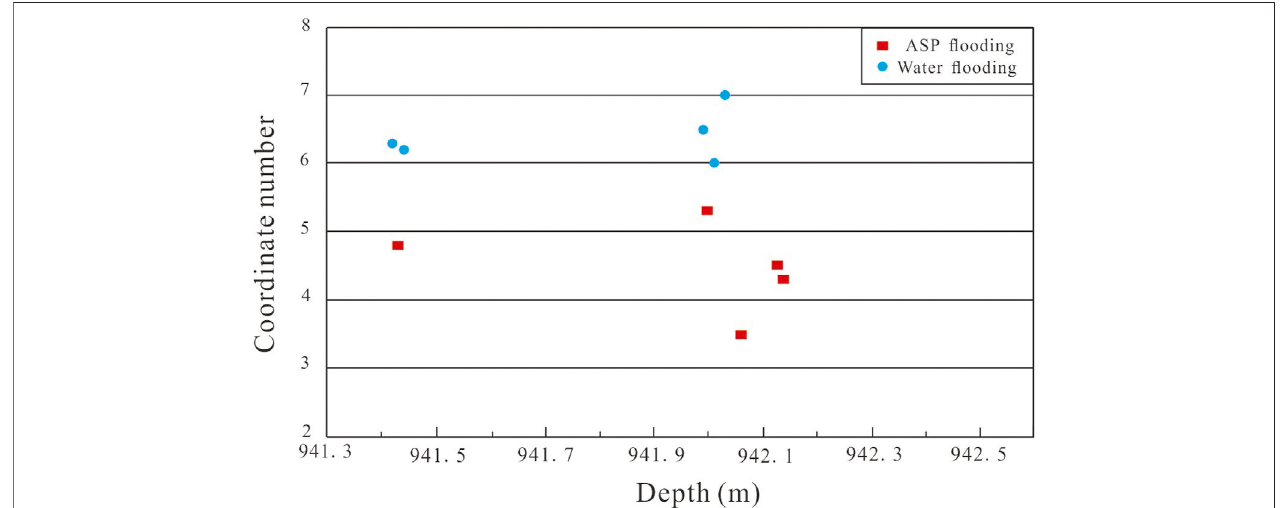
FIGURE 7 | Variation characteristics of pore throat coordinate number before and after ASP fl ooding.